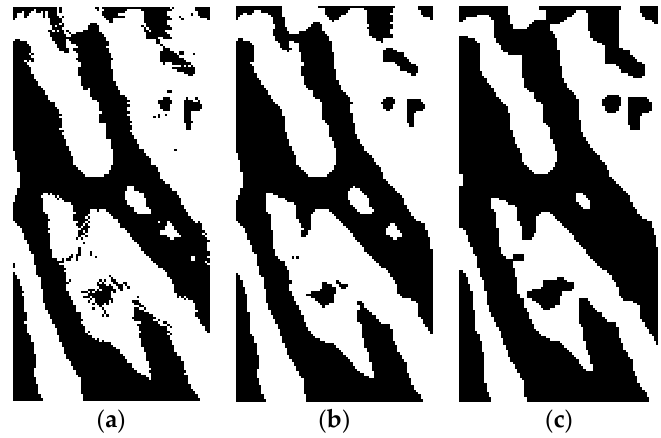
Figure 5. Process of bloodstream filtration: ( a ) after thresholding (left), ( b ) after median filtration (middle), and ( c ) after dilatation and erosion (right).